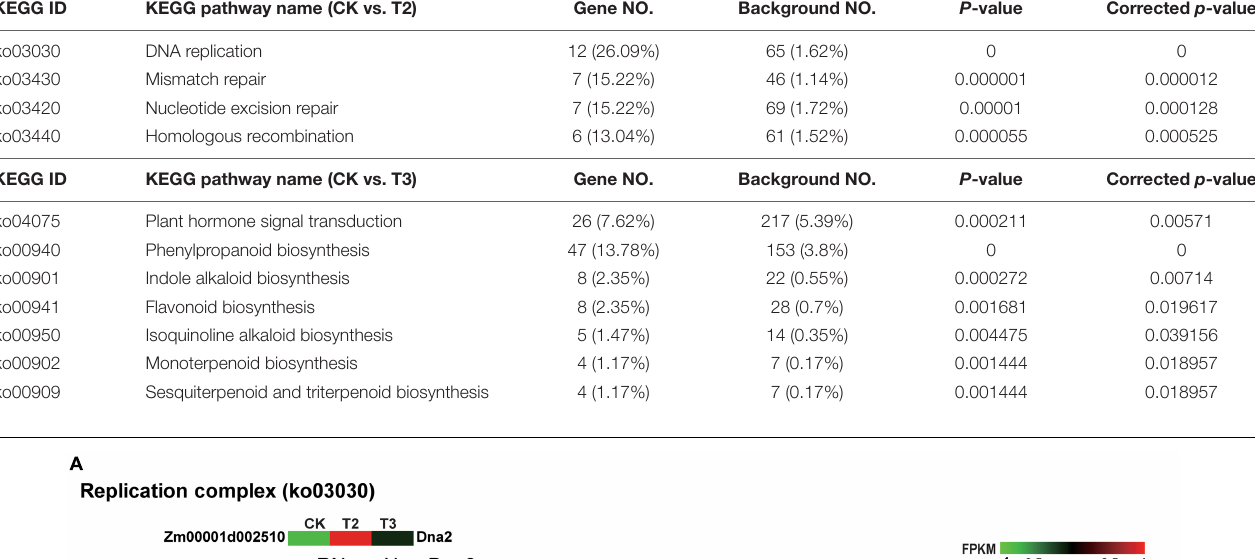
TABLE 2 | Kyoto Encyclopedia of Genes and Genomes (KEGG) pathway enrichment analysis of differentially expressed genes (DEGs) in different comparison groups: CK vs. T2 and CK vs. T3. KEGG ID KEGG pathway name (CK vs. T2) Gene NO. Background NO.